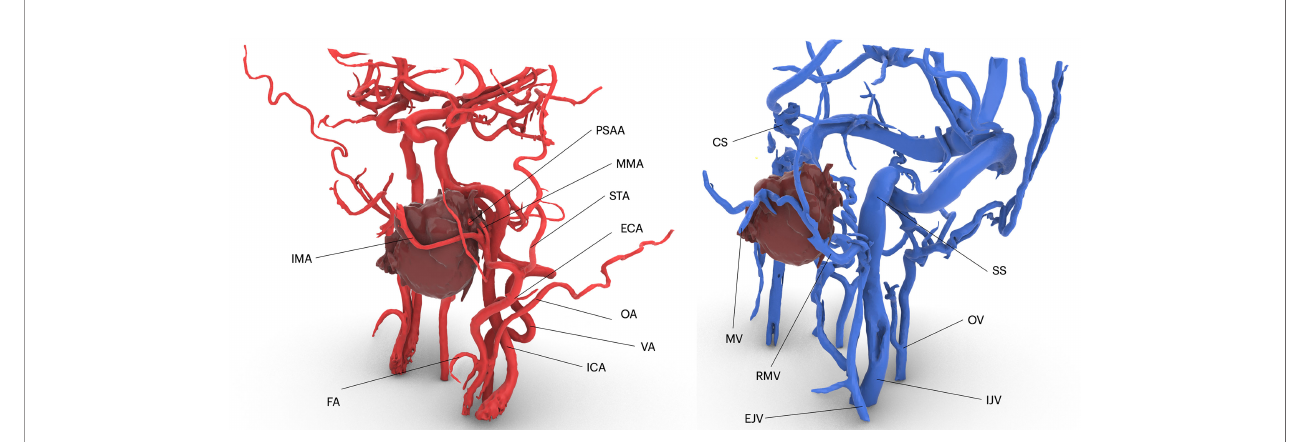
FIGURE 2 | Virtual vascularization study conducted on three-dimensional models of arterial and venous vasculature, respectively derived from 3D TOF MR sequences and phase-contrast venography. IMA, internal maxillary artery; FA, facial artery; ICA, internal carotid artery; VA, vertebral artery; OA, occipital artery; ECA, external carotid artery; STA, super fi cial temporal artery; MMA, middle meningeal artery; PSAA, posterior superior alveolar artery; CS, cavernous sinus; M, maxillary vein; SS, sigmoid sinus; OV, occipital vein; RMV, retromandibular vein.